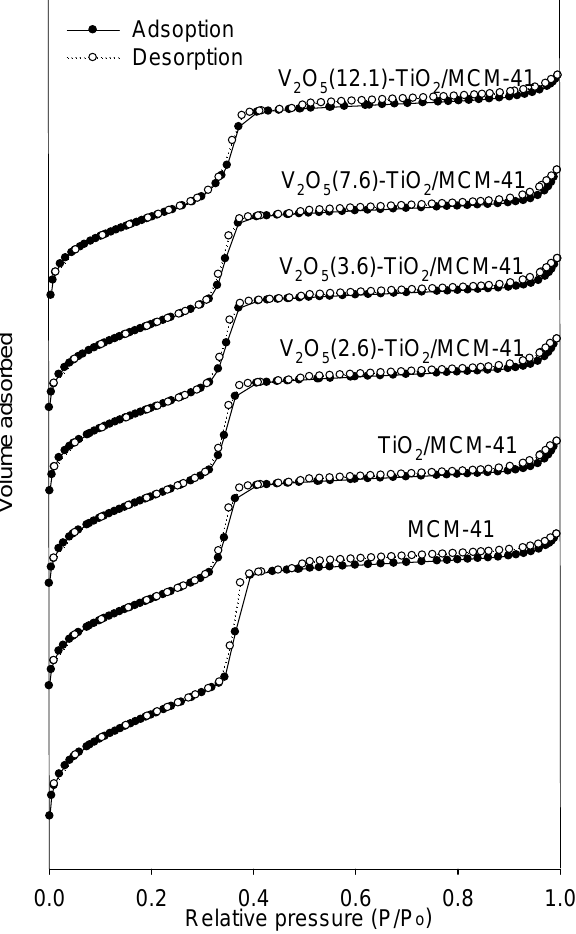
Figure 2. N adsorption–desorption isotherms of various 2